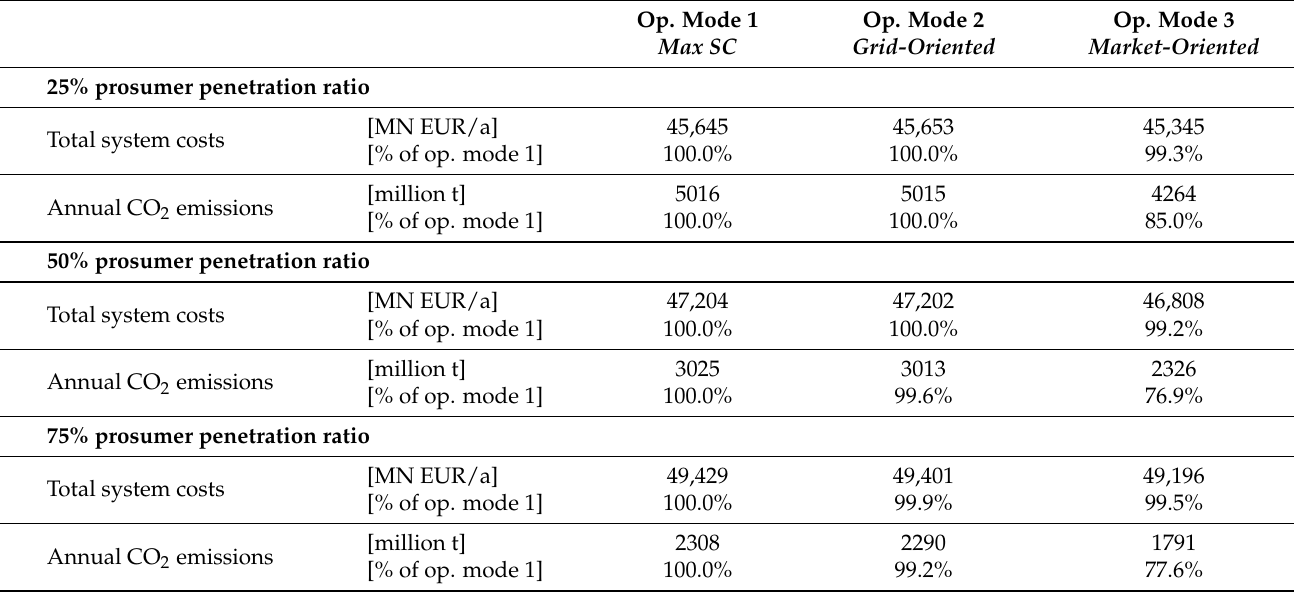
Figure 4. Annualized total system costs and CO 2 emissions, normalized in % of respective values for battery operation mode 1, by battery operation mode, for 50% prosumer penetration ratio. Table 4. Summary of system